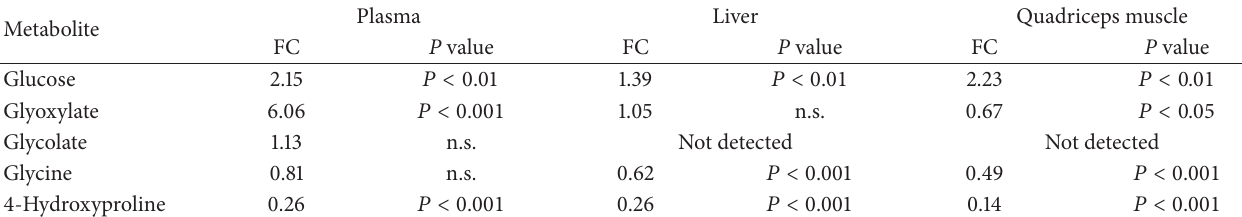
Table2:Comparisonof db/db − / − andwild-typemiceforplasmaandtissuelevelsofglyoxylateandmetabolitesinvolvedinglyoxylatesynthesis or degradation (n.s.: not significant and FC: fold-change db/db − / − relative to wild-type). Plasma Liver Metabolite FC